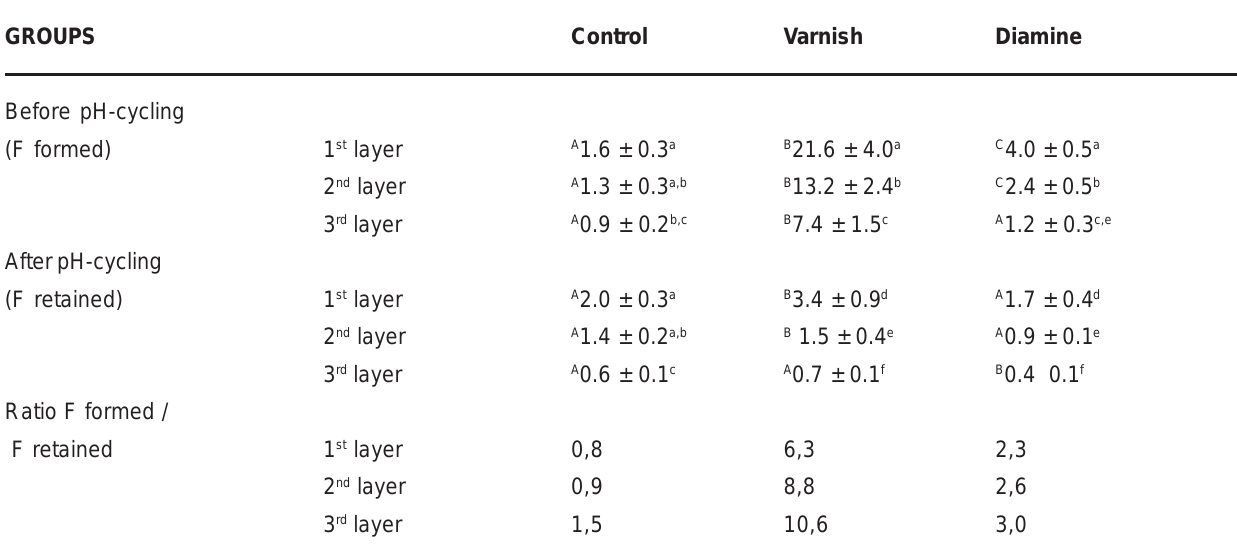
Mean values followed by different letters are statistically different at 5%. Capital letters show differences between the treatment groups; lower case letters show differences between the enamel layers removed within the same